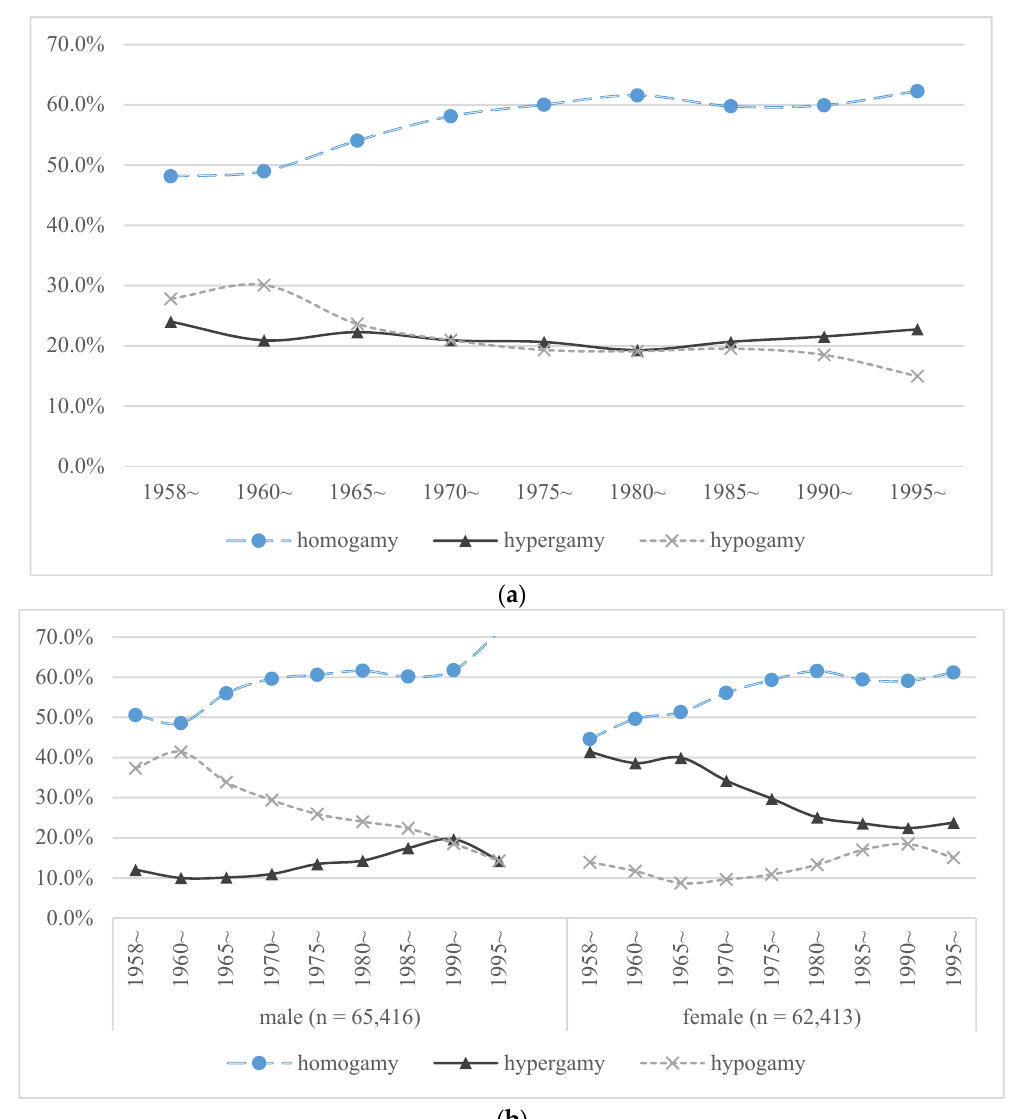
Figure 2. ( a ). Evolution of educational assortative mating with birth cohort (N = 127,829); ( b ). Evolution of educational assortative mating with birth cohort (Gender ‐ specific outcomes).